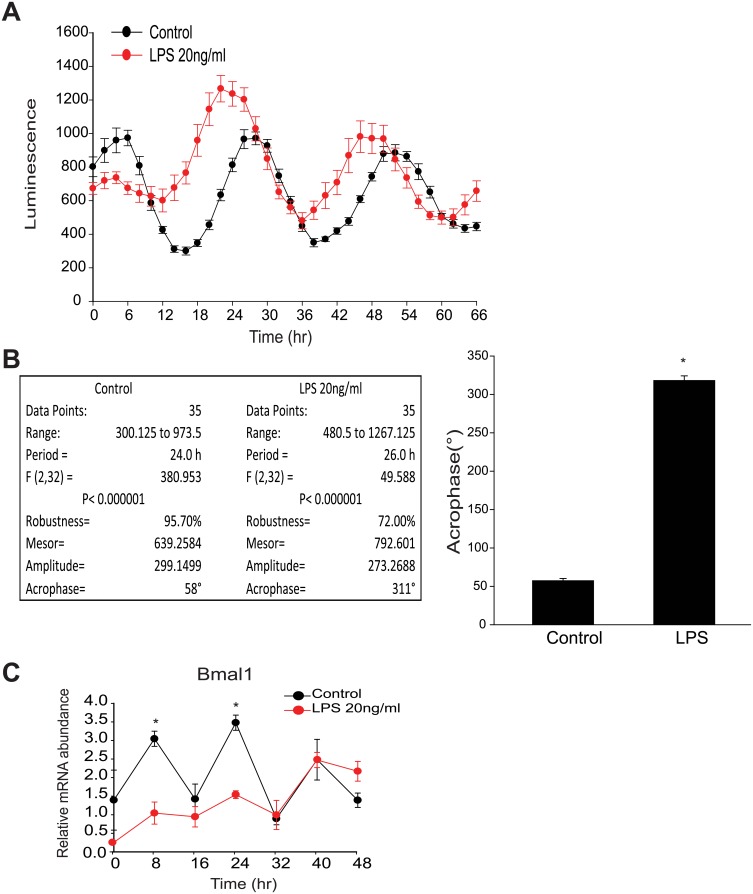
LPS induces a phase shift in synchronized peritoneal macrophages and impairs the expression of core circadian genes in peritoneal macrophages.(A) Peritoneal macrophages from mPer2luciferase transgenic mice were seeded in 96-well plate (white) for 24 hours. After 2h serum shock, cells were kept in luminescence buffer in presence or absence of LPS (20ng/ml) and bioluminescence was recorded every 2 hours which starts from Time 0. (B) Oscillation curves were analyzed by cosinor (time 0 and 24h represented by 0° and 360°, respectfully) and acrophase determined (mean ± SEM, n = 8, t-test, * p<0.05, versus Control). (C) Peritoneal macrophages were synchronized and mRNA levels of Bmal1 and 18S were assessed every 8h with qRT-PCR in presence or absence of LPS (20ng/ml). Transcript abundance (ΔΔCt) was reported relative to Time 0 in the control group (mean ± SEM, n = 5, one-way ANOVA with Bonferroni post hoc correction, *p<0.05, versus control).